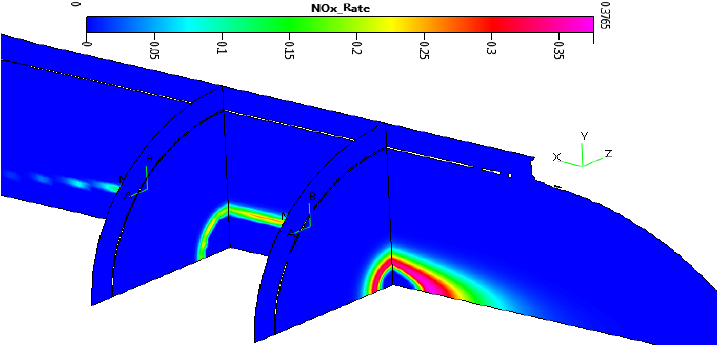
Figure 8. NO production rate on the symmetry plane and on two different normal x cuts. x